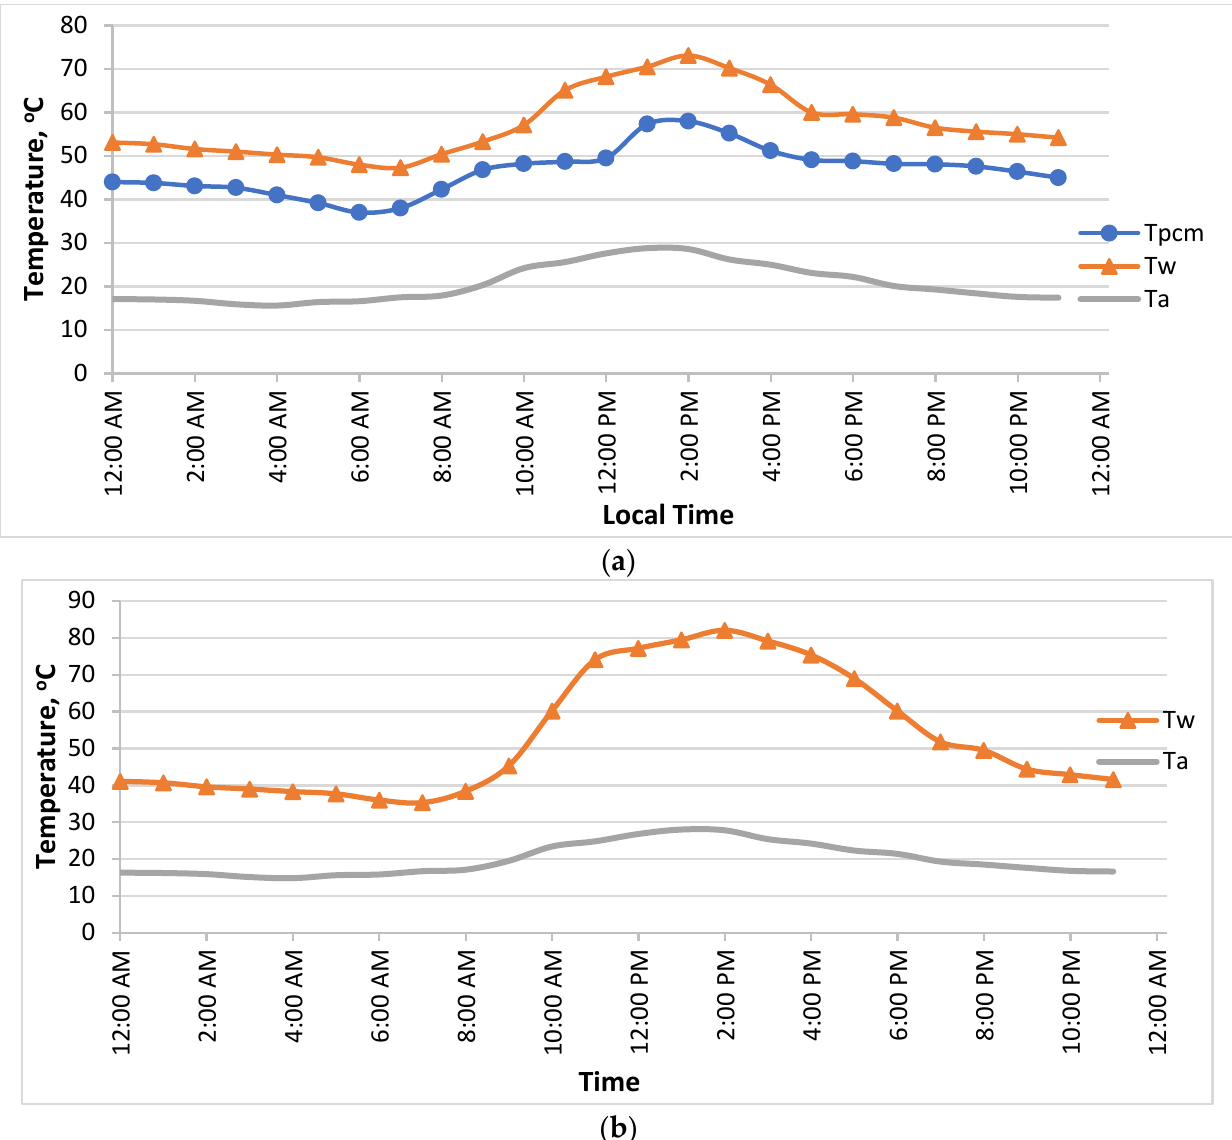
Figure 7. Temperature distribution of the system through June 2022: ( a ) using paraffin as PCM; ( b ) without PCM.